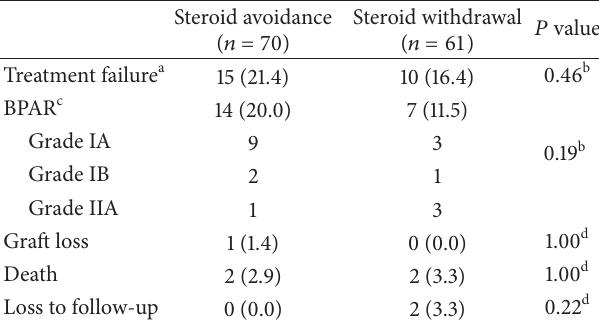
Table 3: Efficacy endpoints at month 36, 𝑛